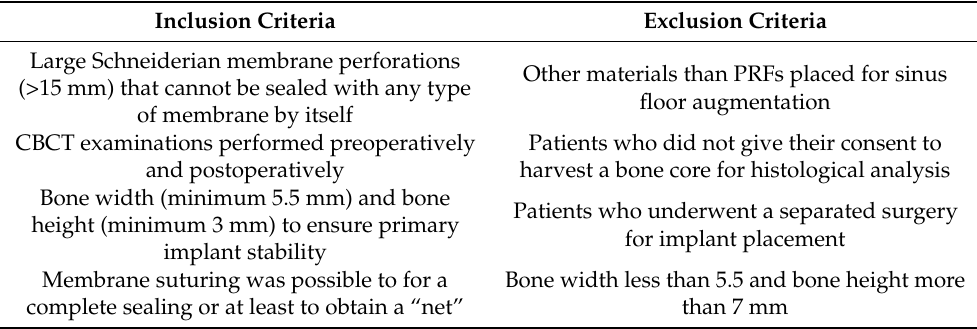
Table 1. Characteristics of the patients included in the